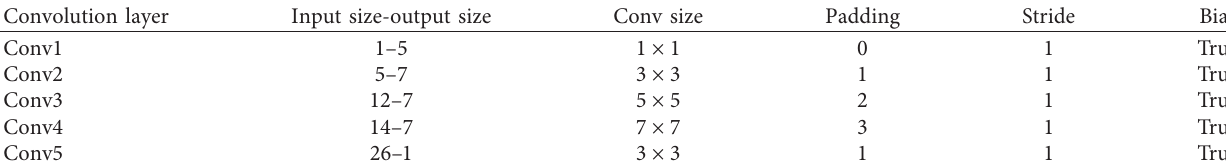
Table 1: Parameters of medium-/high-frequency channel.